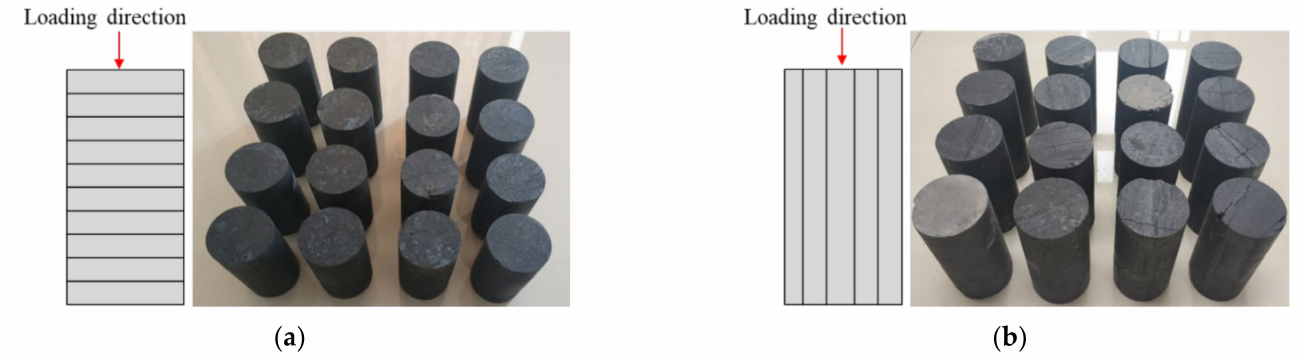
Figure 1. Coal specimens: ( a ) horizontal bedding; ( b ) vertical